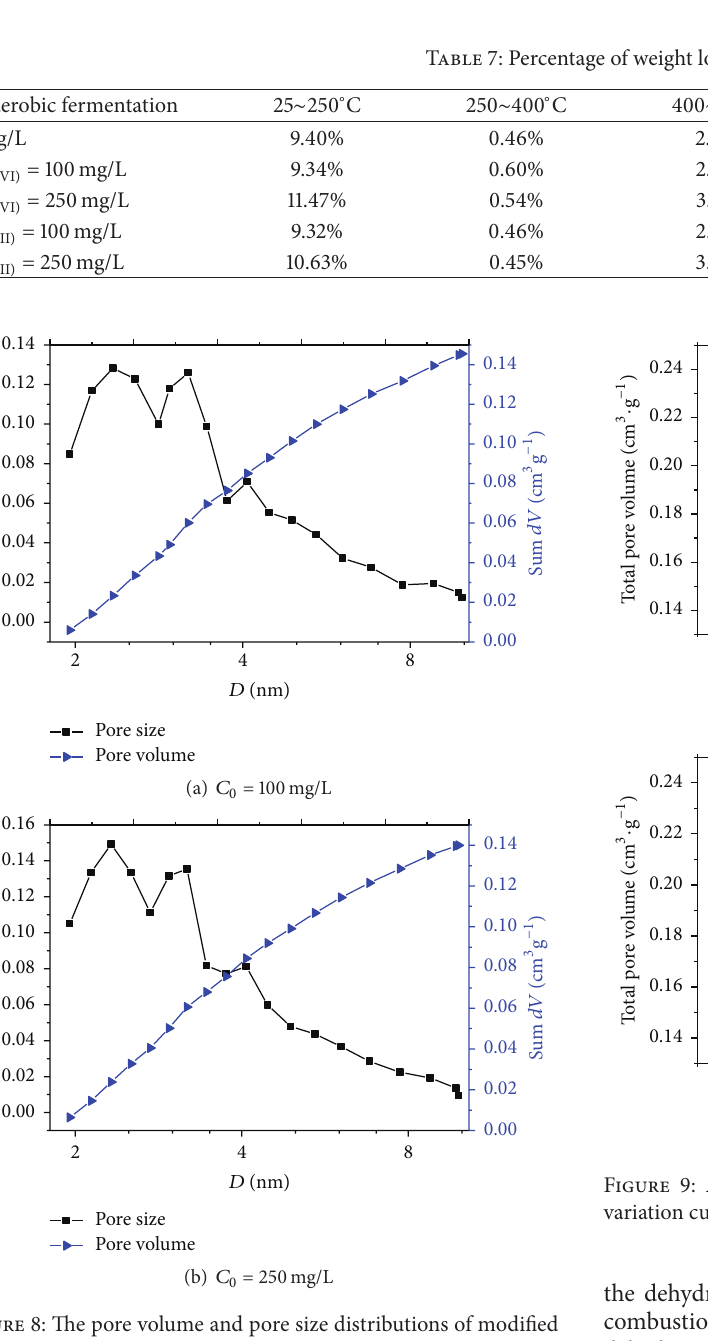
Figure 8: The pore volume and pore size distributions of modified clay after absorbing Pb(II).